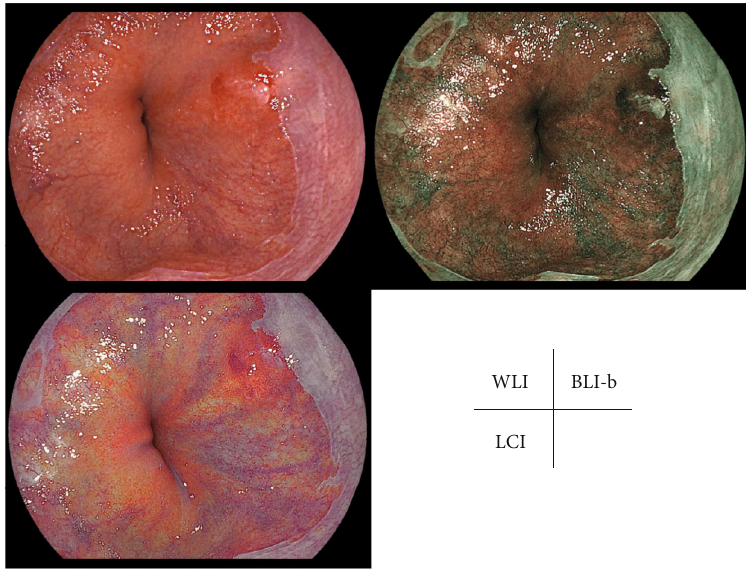
Figure 3: Representative case of esophageal adenocarcinoma. WLI, LCI mode, and BLI-b mode at the same site in a fully extended condition without zooming. Esophageal adenocarcinoma was resected via ESD and was pathologically con fi rmed as Barrett ’ s